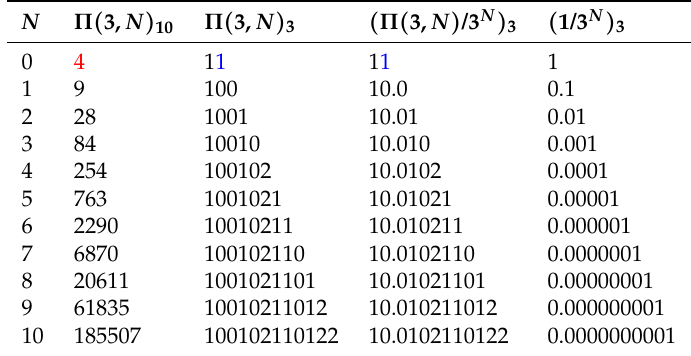
254 100102 10.0102 0.0001 763 1001021 10.01021 0.00001 2290